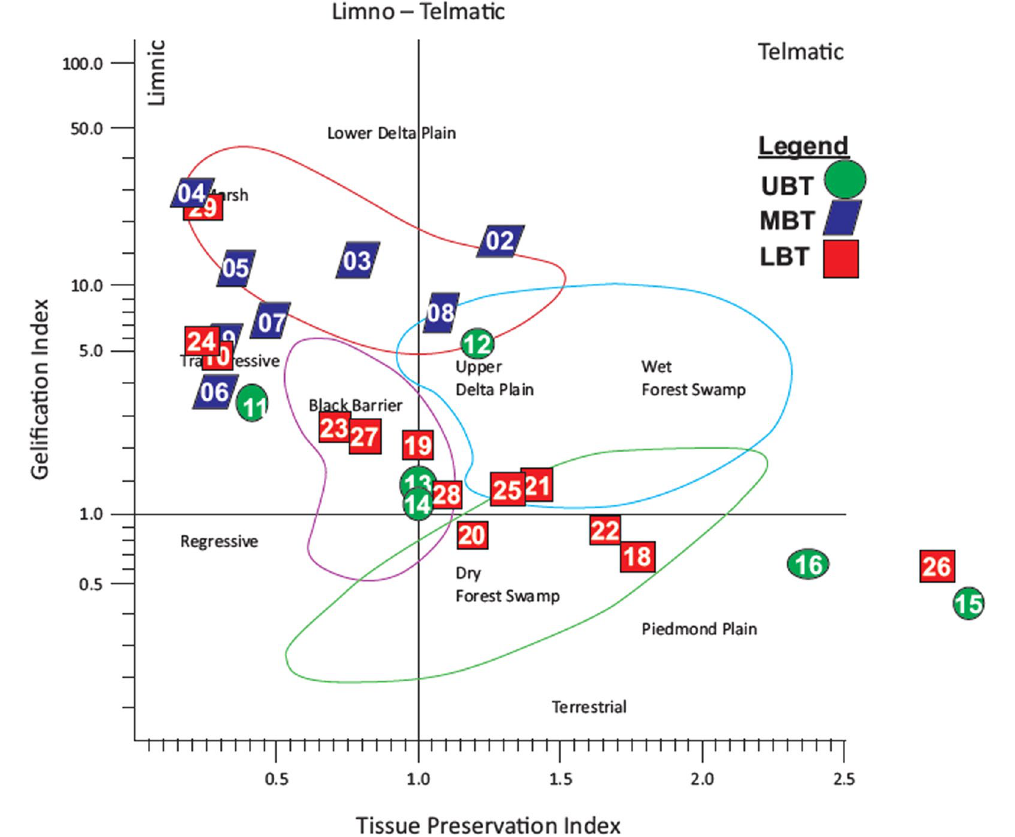
Fig. 7 Coal facies diagram for the coals within the Benue Trough using Eqs. (1) and